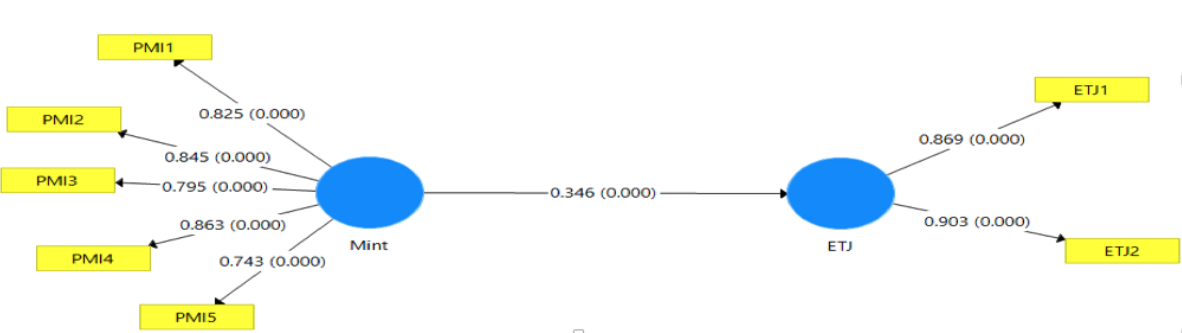
Figure 4: Model Results; Source: Smart Pls 3